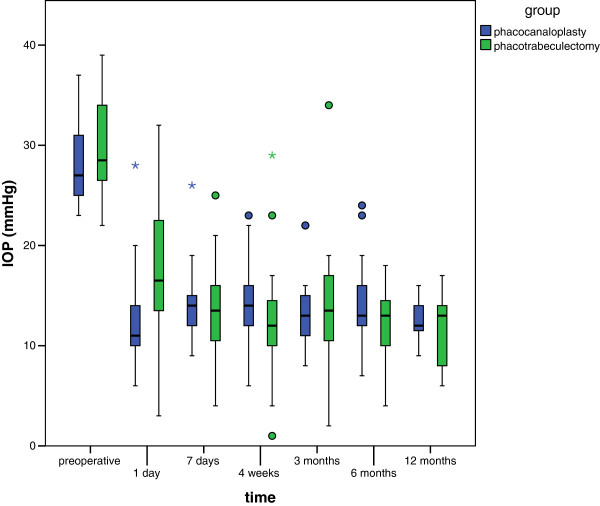
Intraocular pressure (IOP) outcomes of phacotrabeculectomy and phacocanaloplasty during follow-up. A highly significant reduction of IOP was found for both groups during follow-up (P < .0001). Except for the first postoperative day, statistical analyses revealed no significant difference for postoperative IOP results between both groups. Box plots illustrate the median (50th percentile) as a black center line and the 25th and 75th percentile as the lower and upper hinges of the box. Circles represent minor outliers and stars major outliers.